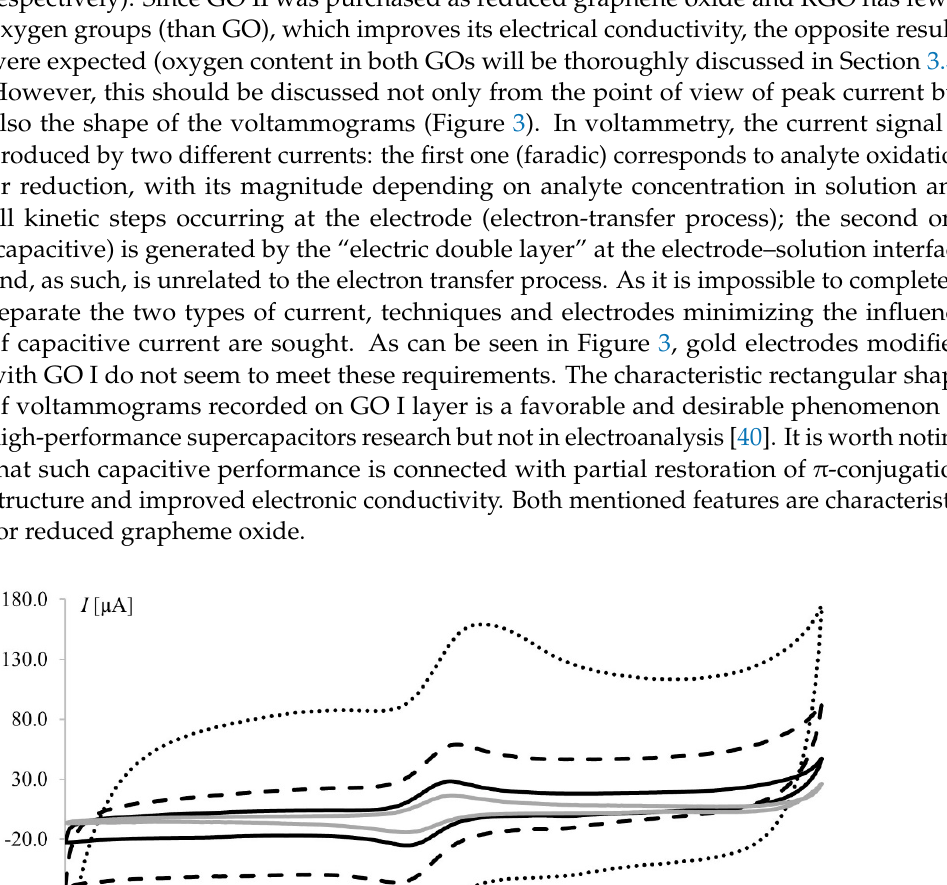
Figure 4. Signal separation measured for Au ( A ) and Pt ( B ) electrodes modified with GO I and GO II.